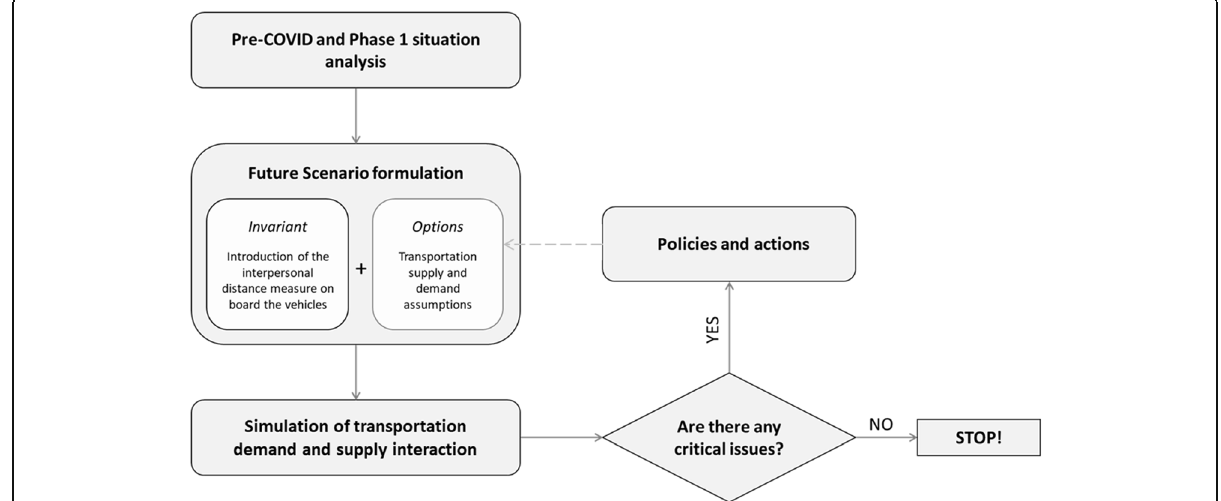
Fig. 3 Schematic representation of the proposed methodology to identify PT system critical